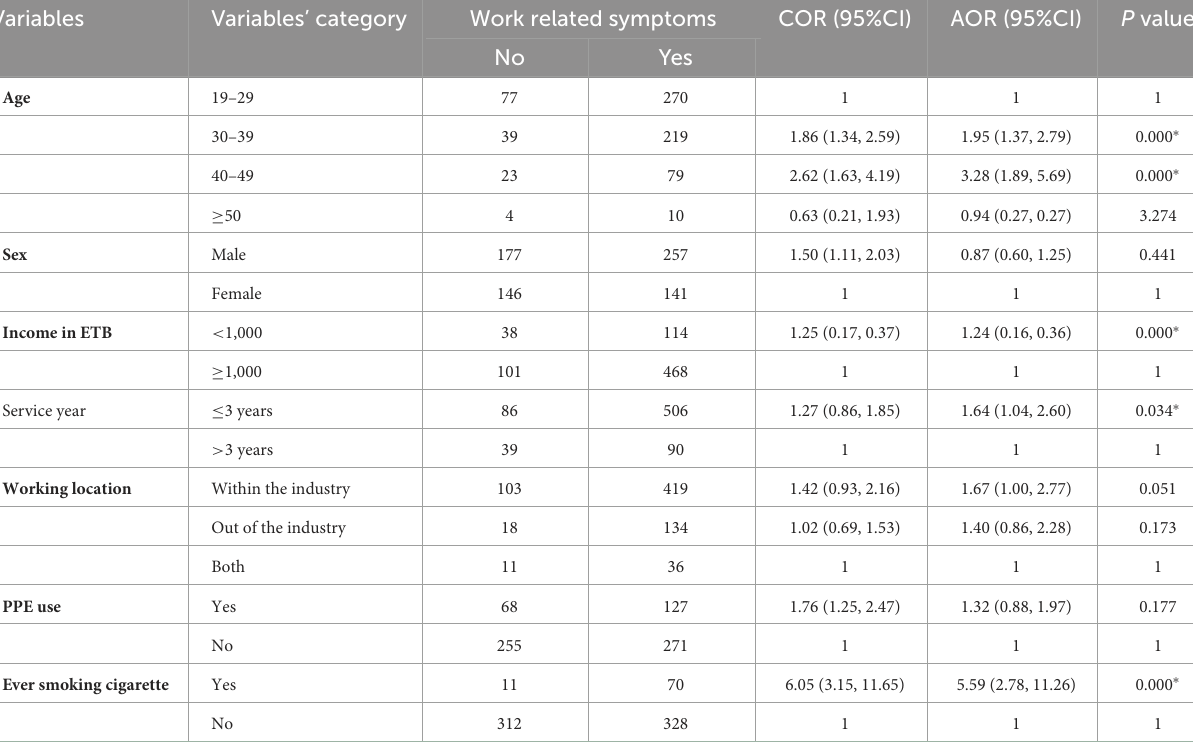
TABLE 4 Factors associated with work-related disease symptoms among workers in coffee industries, Bench-Sheko and Kafa Zones, May/2021.